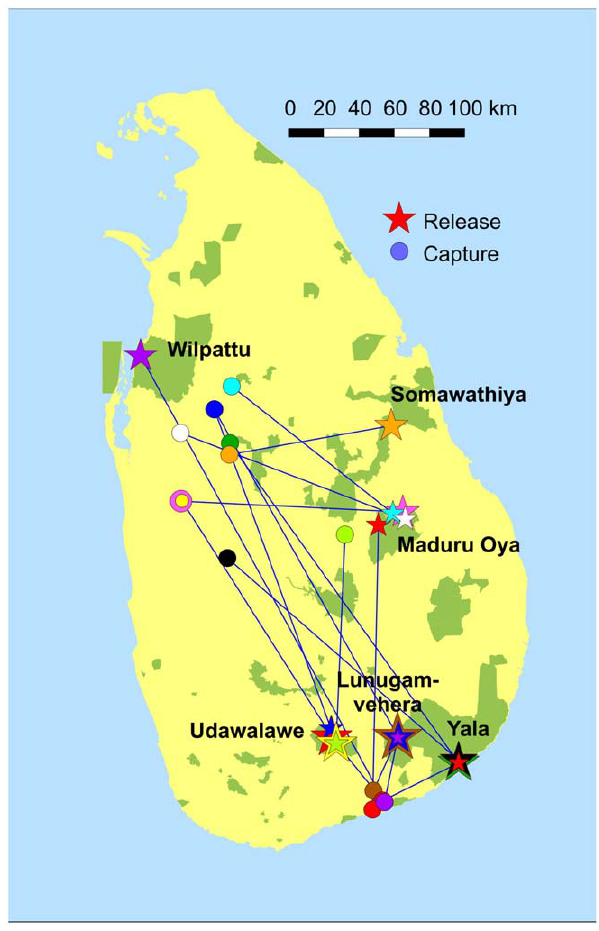
Figure 1. Map of translocations. Circles indicate capture sites and stars release sites. Different colors denote individual elephants. Green polygons represent protected areas under the Department of Wildlife Conservation.